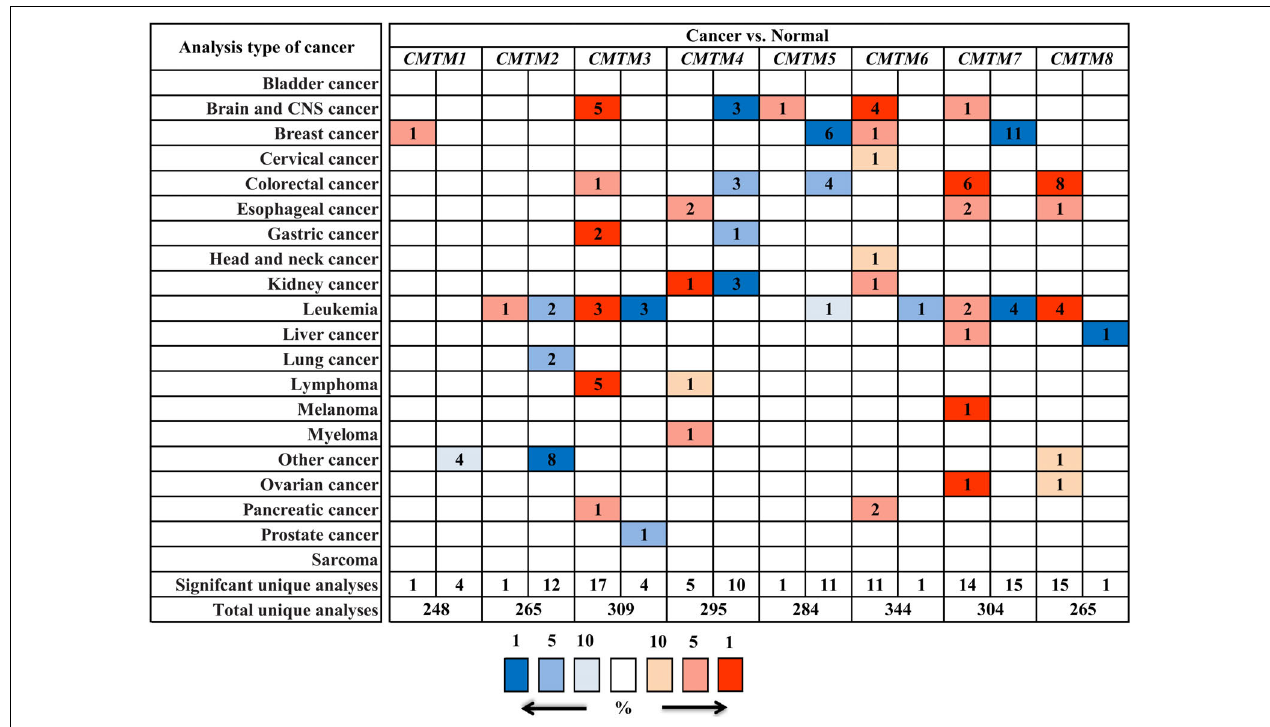
FIGURE 1 | mRNA expression levels of CMTM family members in different human cancers and corresponding normal tissues from the Oncomine